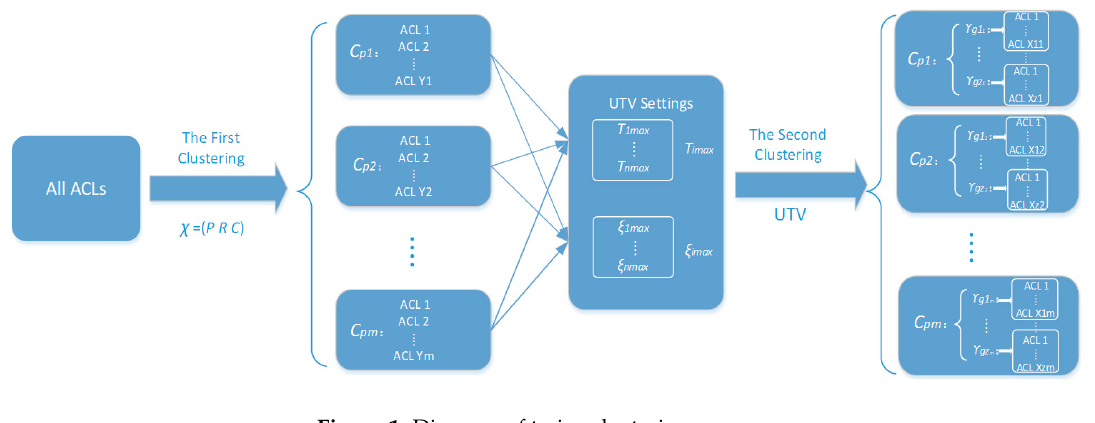
Figure 1. Diagram of twice-clustering process.